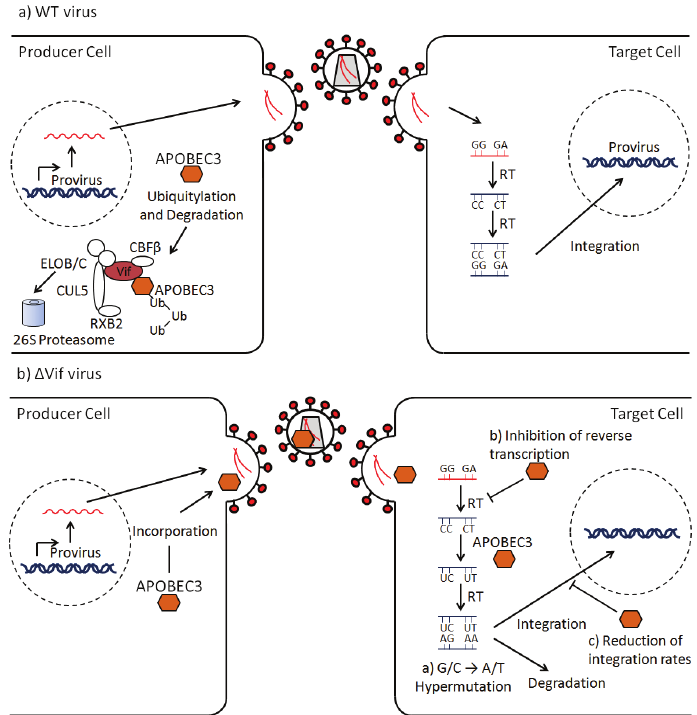
Figure 2. Schematic representation of the mechanisms of action of the HIV-1 Vif protein and APOBEC3. ( a ) Vif-induced degradation of APOBEC3 in infection by a WT virus (with a functional Vif protein). ( b ) APOBEC3 incorporation into Δ Vif virions and antiviral effects in the target cell. See text for further